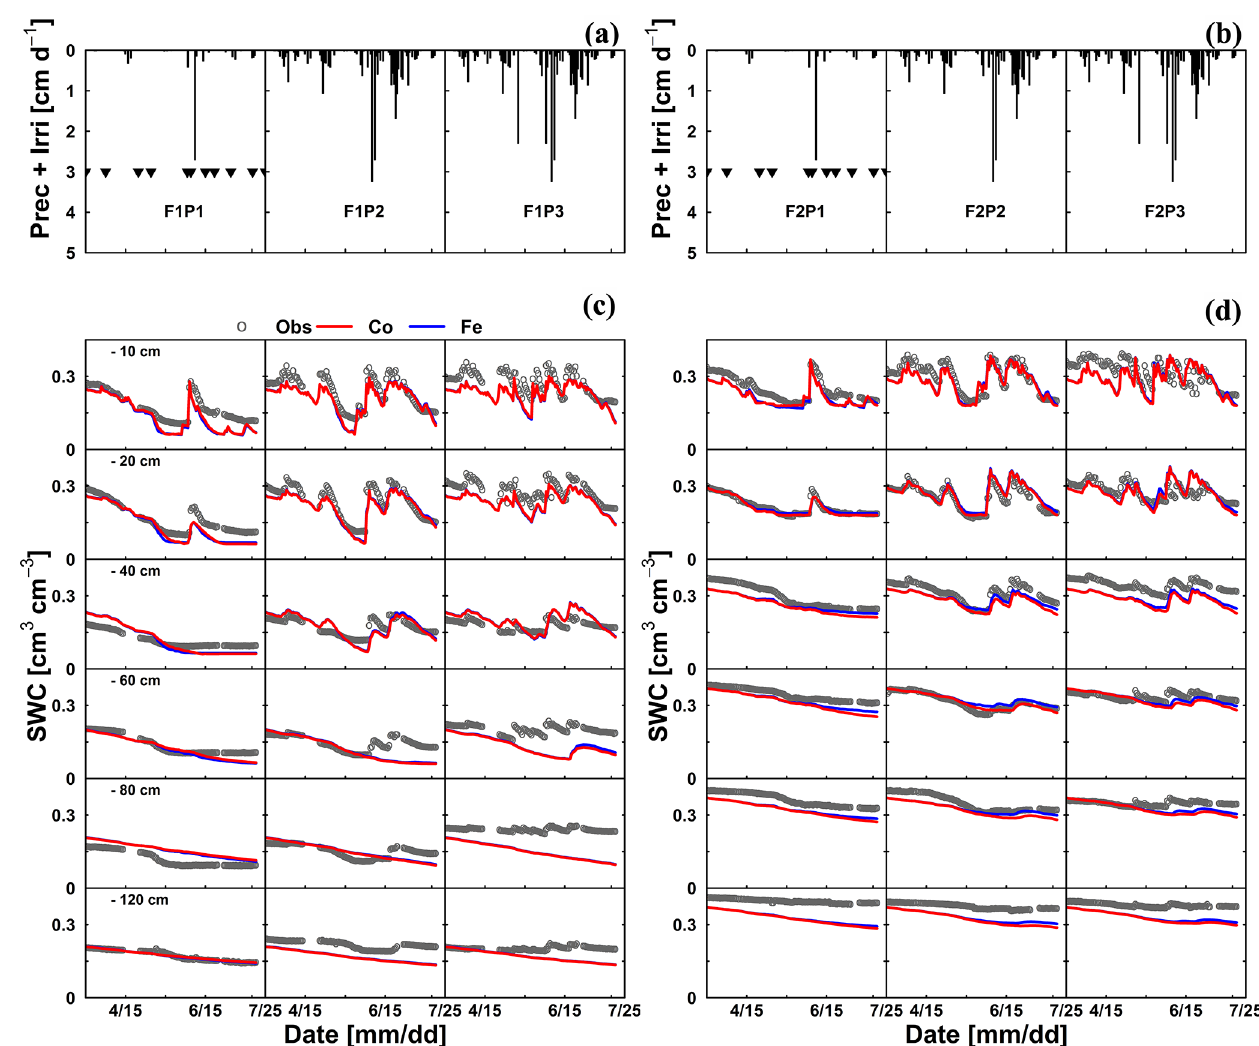
Figure 8. Illustrations of (a, b) time series of precipitation (Prec) and irrigation (Irri) and comparison between observed (black) and simulated soil water content (SWC) by the Couvreur (Co; solid red) and Feddes RWU model (Fe; solid blue) at six soil depths in the sheltered (P1), rainfed (P2), and irrigated (P3) plots of (c) the stony soil (F1) and (d) the silty soil (F2) from 15 March to 23 July 2016. Triangle symbols in the sheltered plots (F1P3 and F2P3) indicate the sheltered